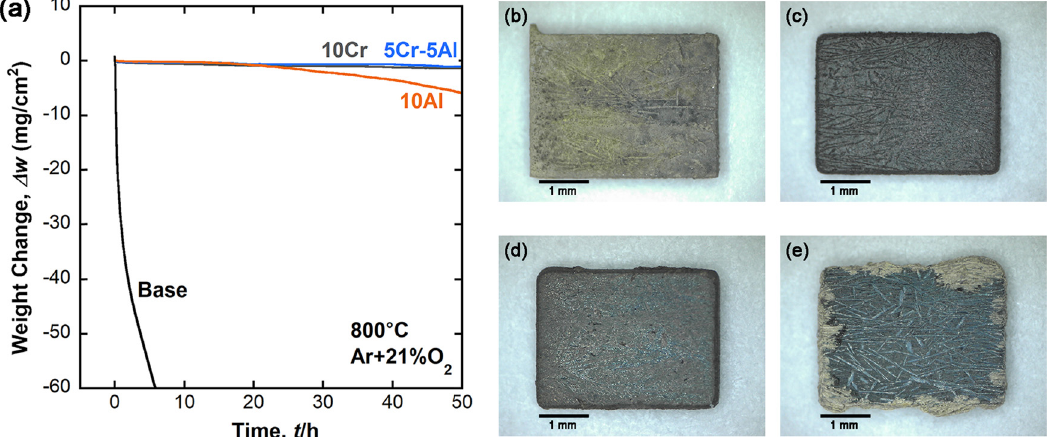
Figure 3: ( a ) Isothermal oxidation curves of the alloys obtained at 800°C and appearances of the specimens of the ( b ) base, ( c ) 10Cr, ( d ) 5Cr5Al and ( e ) 10Al alloys oxidized for 50